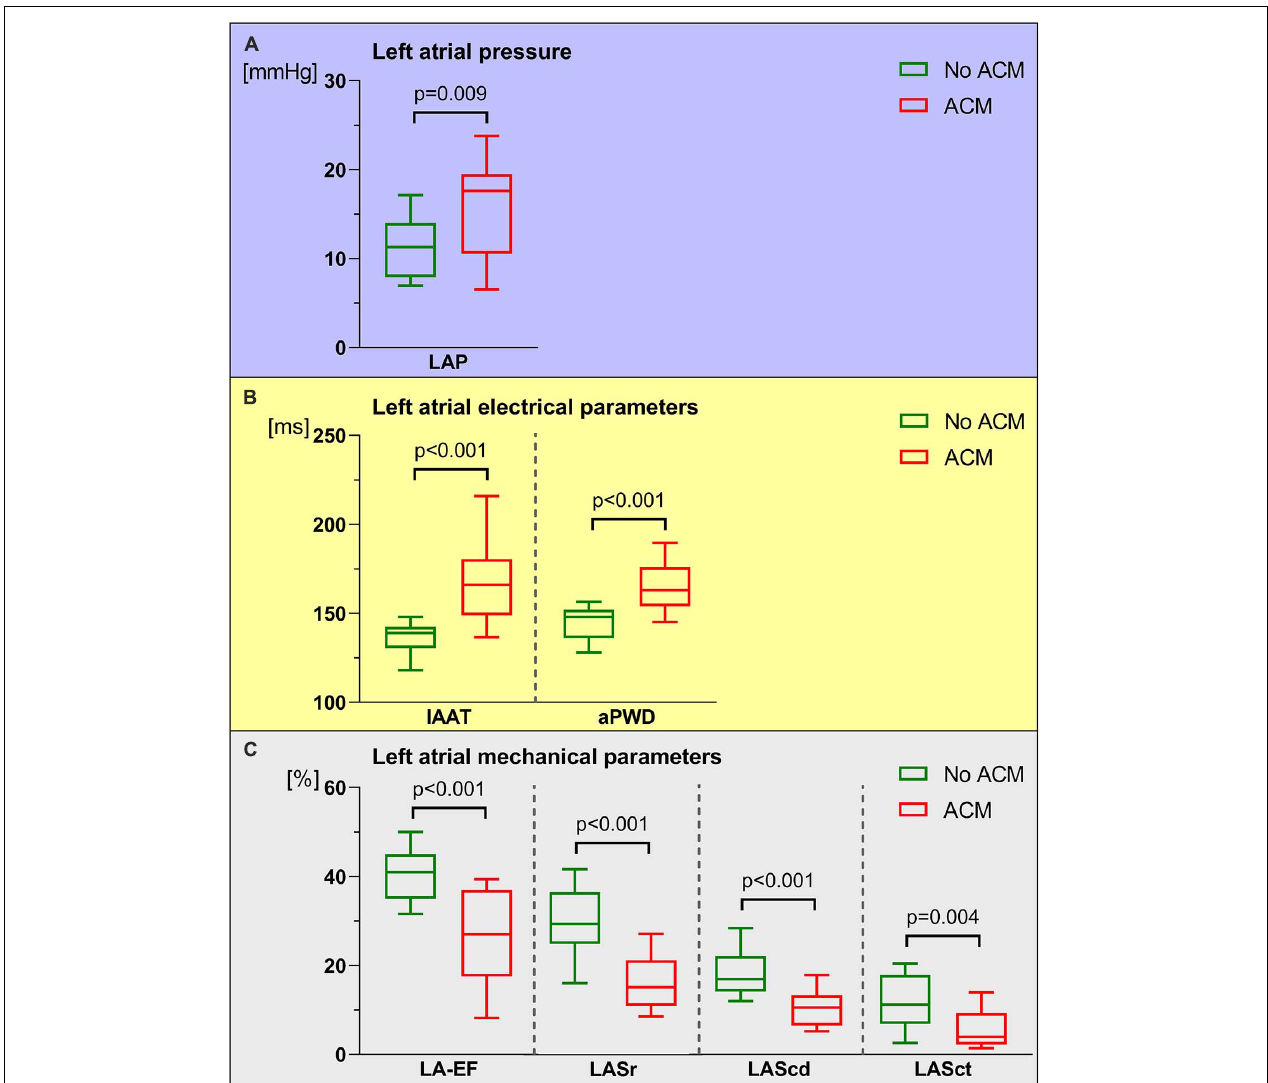
FIGURE 1 | Comparison between left atrial pressure (LAP), left atrial electrical and left atrial mechanical parameters in patients with and without atrial cardiomyopathy (ACM). In patients with ACM (red boxes and whiskers), LAP (A) and left atrial electrical parameters [invasive atrial activation time (IAAT), amplified p-wave duration (aPWD), (B) ] were significantly increased. In contrast, left atrial mechanical parameters [left atrial emptying fraction (LA-EF), left atrial strain during reservoir phase (LASr), conduit phase (LAScd), and contraction phase (LASct), (C) were significantly reduced in ACM compared to patients without ACM (green boxes and whiskers). Boxes include data between lower and upper quartiles and whiskers mark 10th and 90th